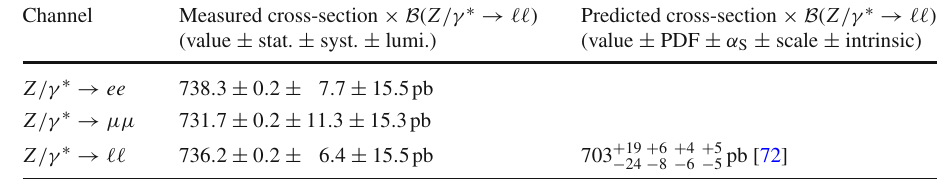
Table 3 Measured integrated Channel Measured cross-section × B ( Z /γ ∗ → (cid:3)(cid:3) ) Predicted cross-section × B ( Z /γ ∗ → (cid:3)(cid:3) ) cross-section in the fiducial (value ± stat. ± syst. ± volume in the electron and muon decay channels at Born level and their combination as well as the theory prediction at NNLO in α S using the CT14 PDF set